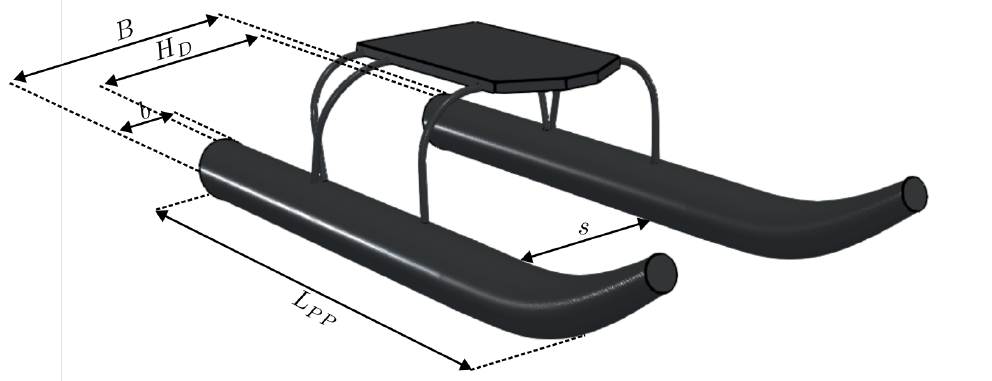
Figure 2. WAM-V 16 CAD